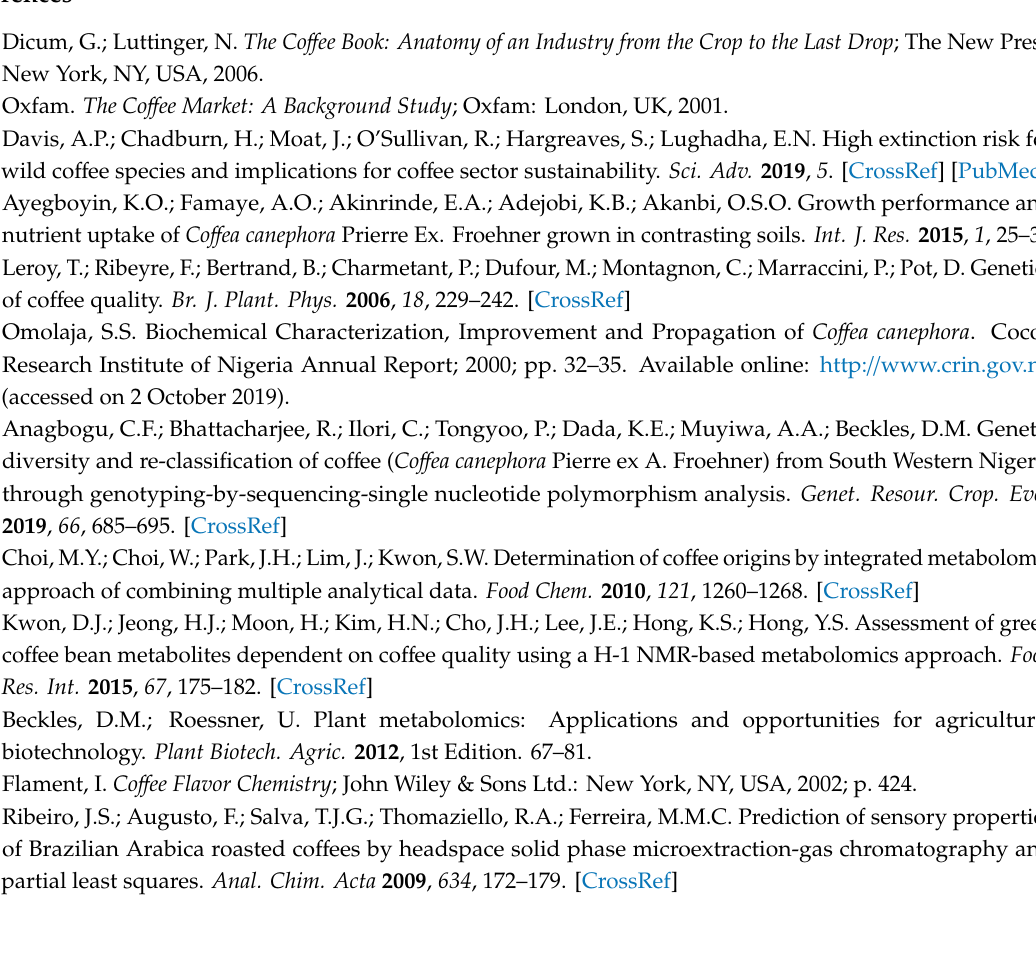
Table S1: The eight classes of metabolites identified in the Nigerian C. canephora co ff ee genotypes, Table S2: Fatty acids with high Pearson’s Coe ffi cient correlative scores (r 2 > 0.80; p < 0.05), Figure S1: Metabolites detected from one-way Analysis of variance that significantly varied across